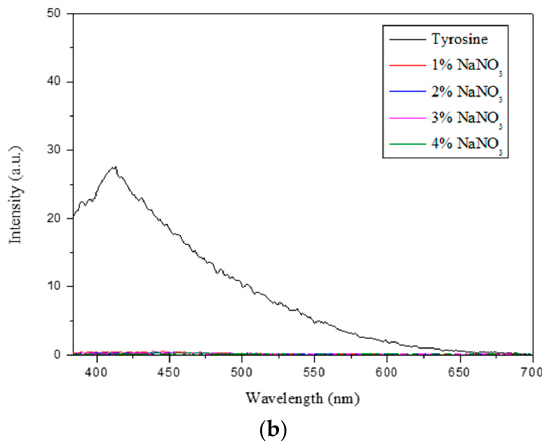
Figure 8. Fluorescence intensity comparison of SF gels: ( a ) 1% to 4% NaNO 3 and ( b ) with tyrosine/formic acid solution (Excitation wavelength: 365 nm).